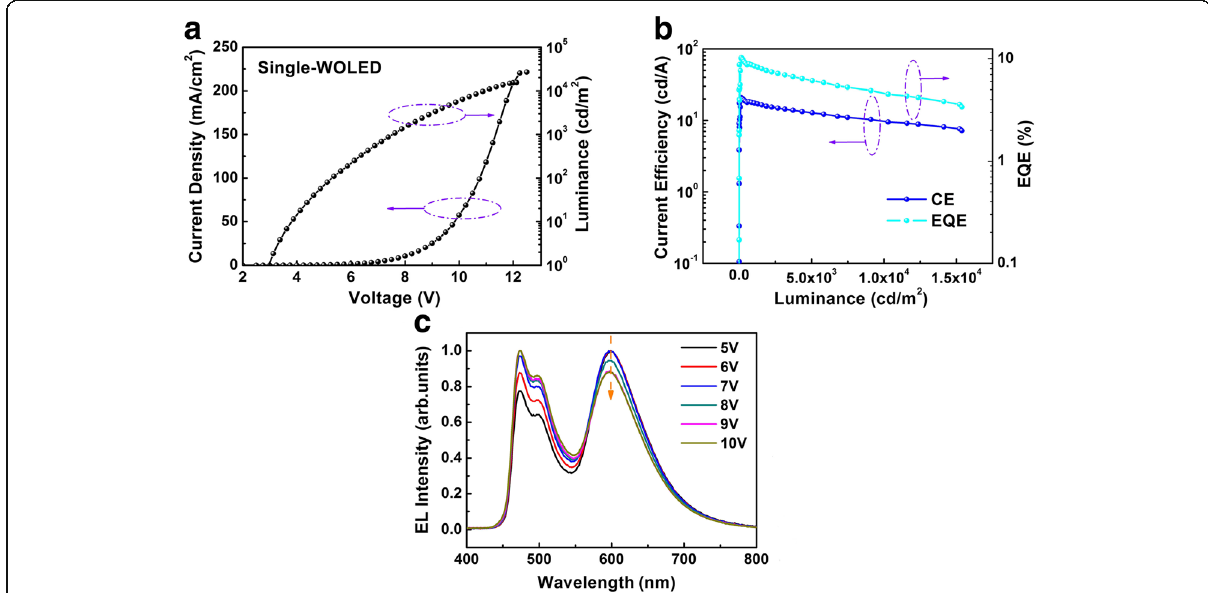
Fig. 7 a Current density – voltage – luminance (J-V-L) curves of the WOLEDs. b Current efficiency – luminance – external quantum efficiency (CE-L-EQE) curves. c Normalized EL spectra of the white OLEDs. The orange arrow shows the weakened spectra versus applied